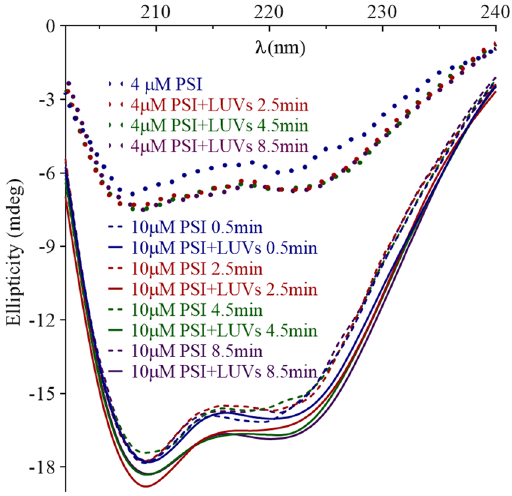
Figure 6. PSI secondary structure upon incubation with bilayer. Far-UV CD spectra were measured over 30 min for PSI incubated with 1:1:1 POPC:POPE:POPS bilayer vesicles (100 µ M total phospholipid) in 50 mM sodium acetate/140 mM NaCl buffer pH 4.5 at 22 °C. Overlapping scans are omitted for